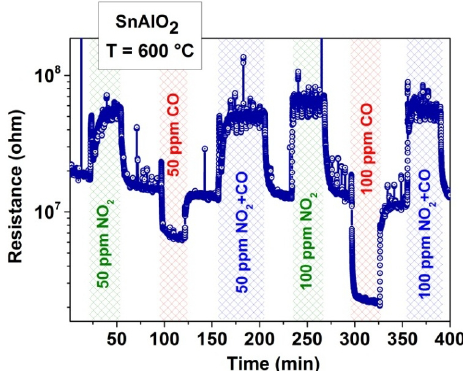
Figure 6. Dynamic response of the Al-doped SnO 2 -based sensor to individual NO 2 or CO and in combination of 50 and 100ppm of NO 2 + CO